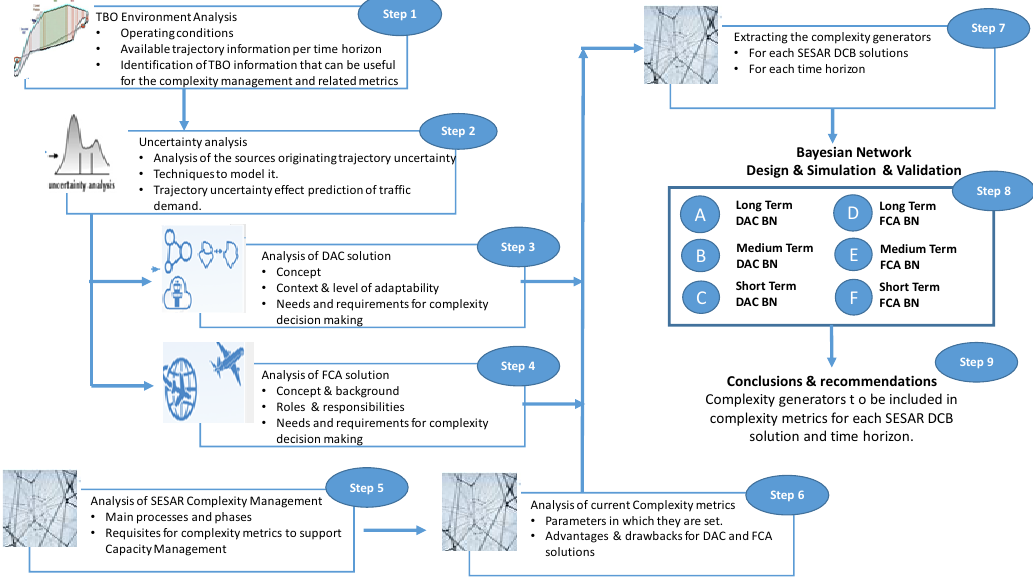
Figure 1. Cotton Figure 1. Cotton Methodology.